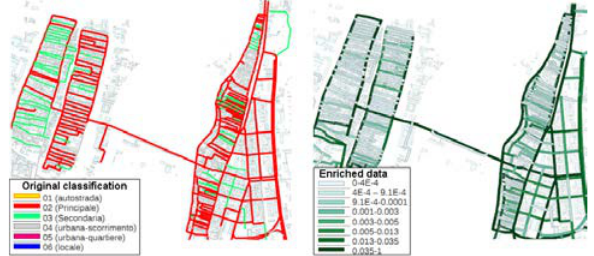
Figure 4. Data enrichment of the classification of roads to perform the